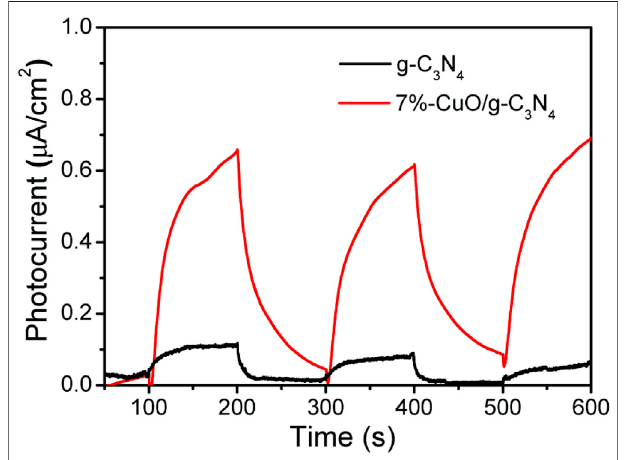
FIGURE 8 | Photocurrent response signals of 7%-CuO/g-C 3 N 4 .